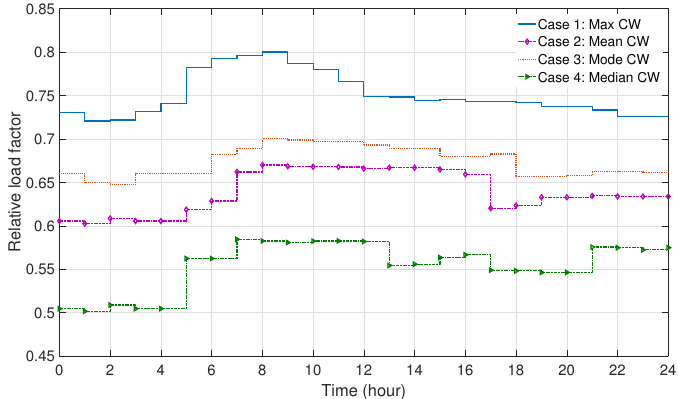
Figure 7. Relative load factor of gas consumption in non-power